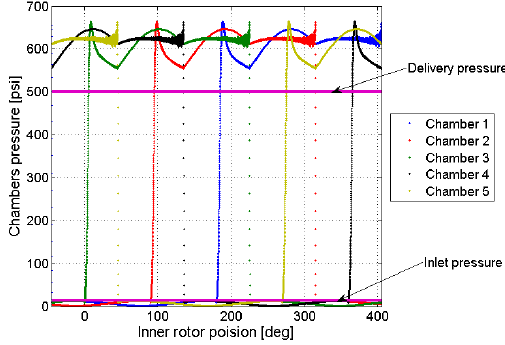
Figure 7. Oil pressure inside the chambers.